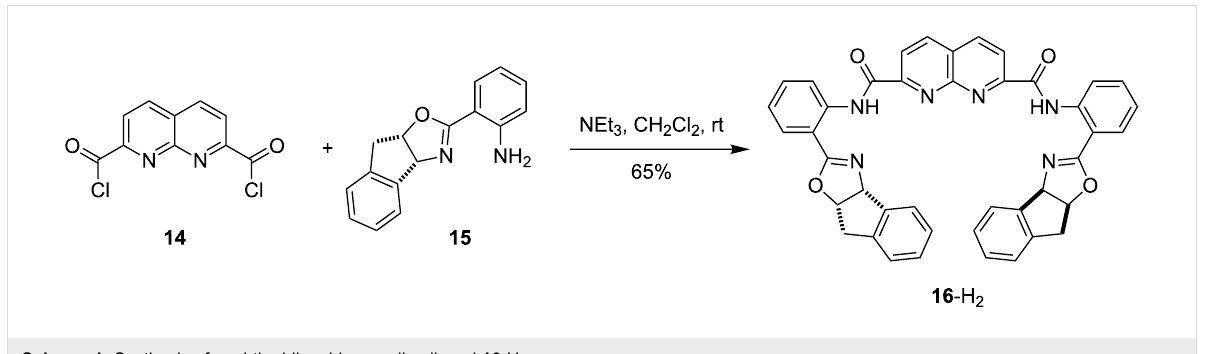
Scheme 1: Synthesis of naphthyridine–bisoxazoline ligand 16 -H 2